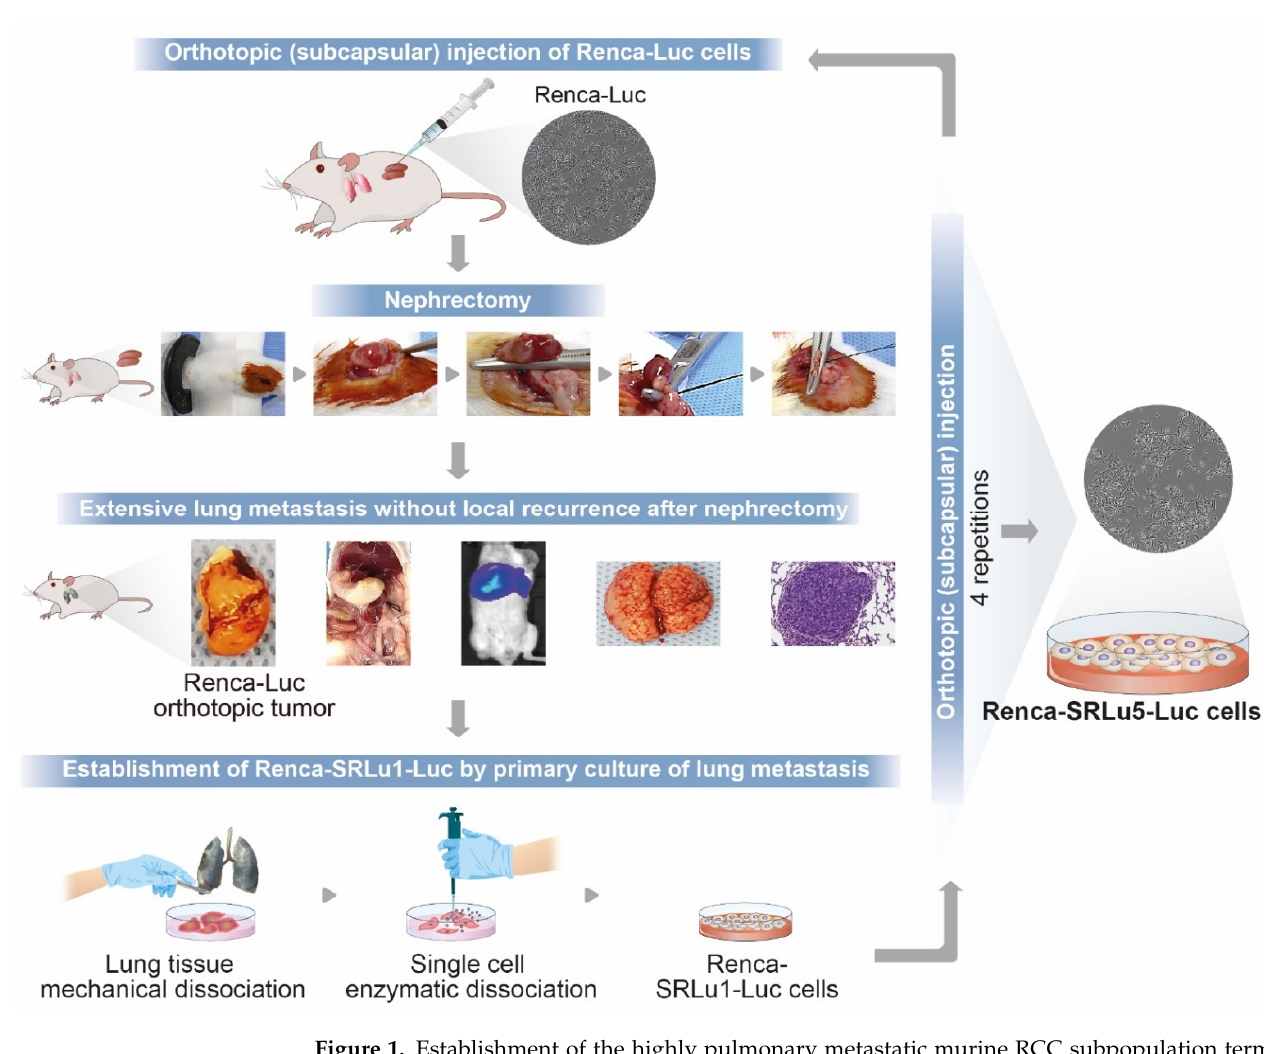
Figure 1. Establishment of the highly pulmonary metastatic murine RCC subpopulation termed Renca-SRLu5-Luc via in vivo serial selection by orthotopic injection and nephrectomy. Schematic representation of the in vivo selection procedures, including subcapsular implantation using a superficial technique, surgical nephrectomy, monitoring of orthotopic tumors, and post-nephrectomy spontaneous lung metastases using bioluminescent imaging, isolation of tumor cells from pulmonary metastases for expansion culture, and reinjection into another mouse.